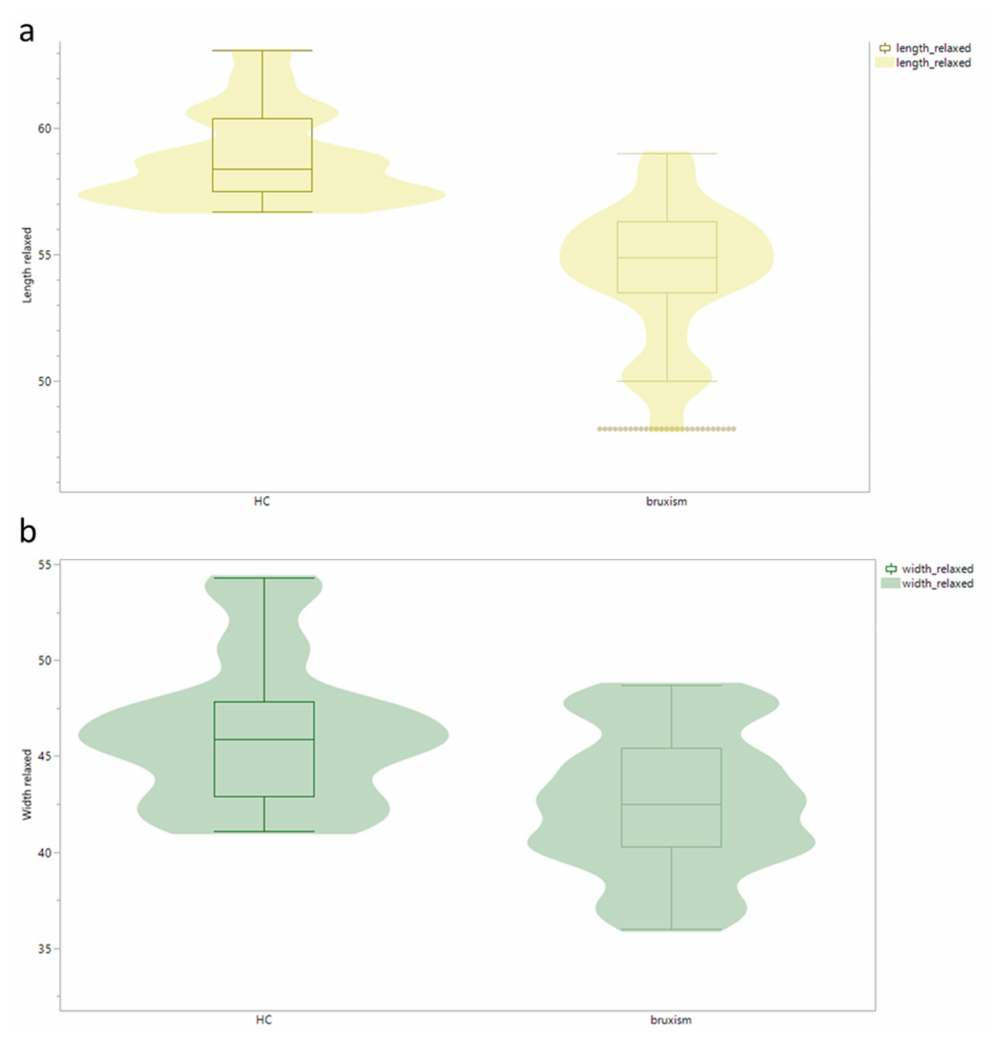
Figure 3. ( a ) Length, and ( b ) width, of the musculus masseter in HC and bruxism patients ( p <